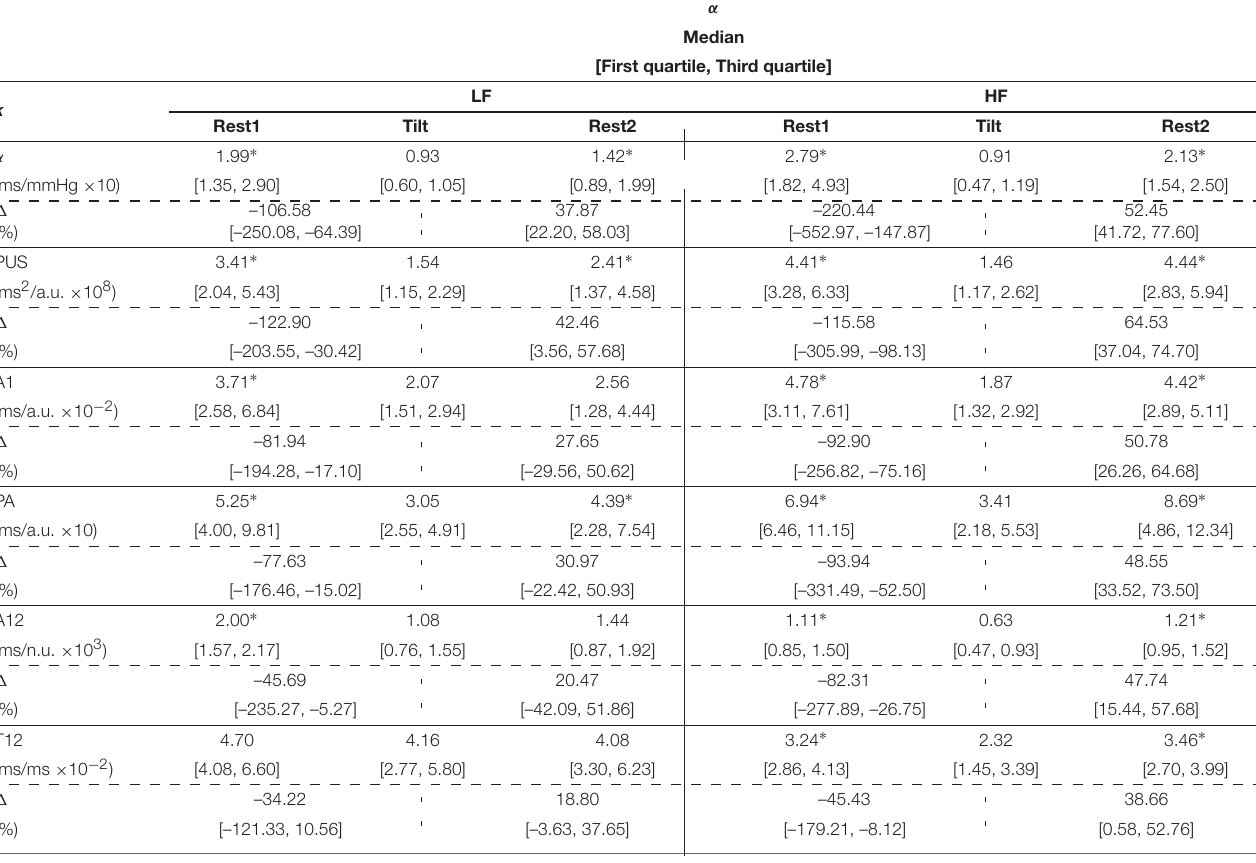
TABLE 2 | Inter-subject median and interquartile ranges of α { LF,HF } and α { LF,HF } k .